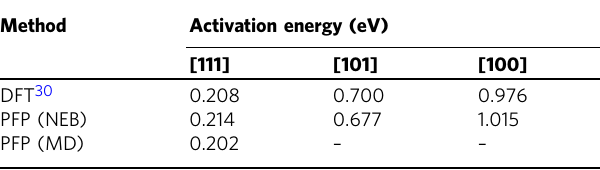
Table 1 Activation energies for lithium diffusion through LiFeSO 4 F at the dilution limit (i.e., through FeSO 4